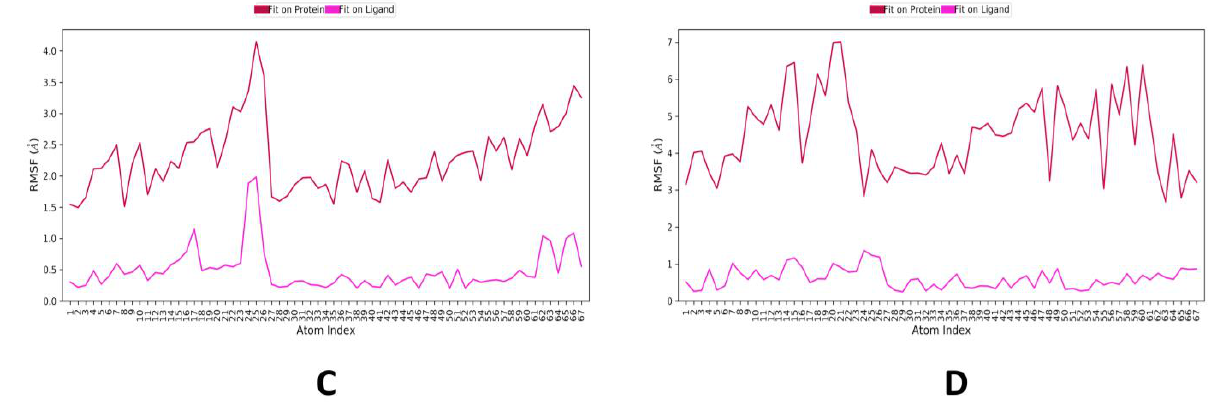
Figure 3. MD simulation protein–ligand interaction root-mean-square fluctuation (RMSF) profile. ( A ) 4YAY-casuarinin, ( B ) 4DLI-casuarinin complex, ( C ) 1HW9-casuarinin complex, ( D ) 1B09-casuarinin complex.